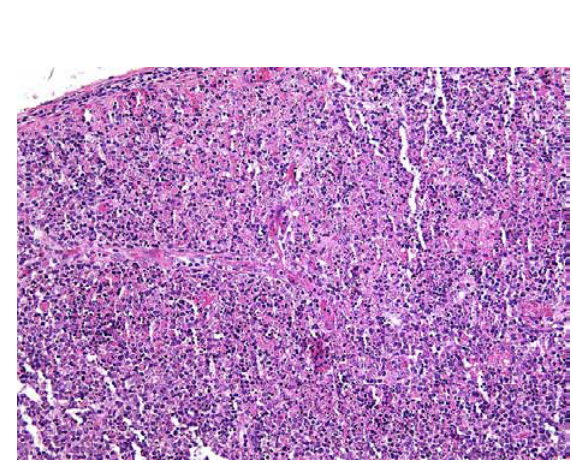
Figure 2. Multifocal necrotic lesions in the lymph node. There is prominent nuclear debris and numerous degenerated mononuclear cells evident in the necrotic lesion. Neither Reed-Sternberg cells nor granulomatous inflammation were identified (Hematoxylin and Eosin staining, ×40).